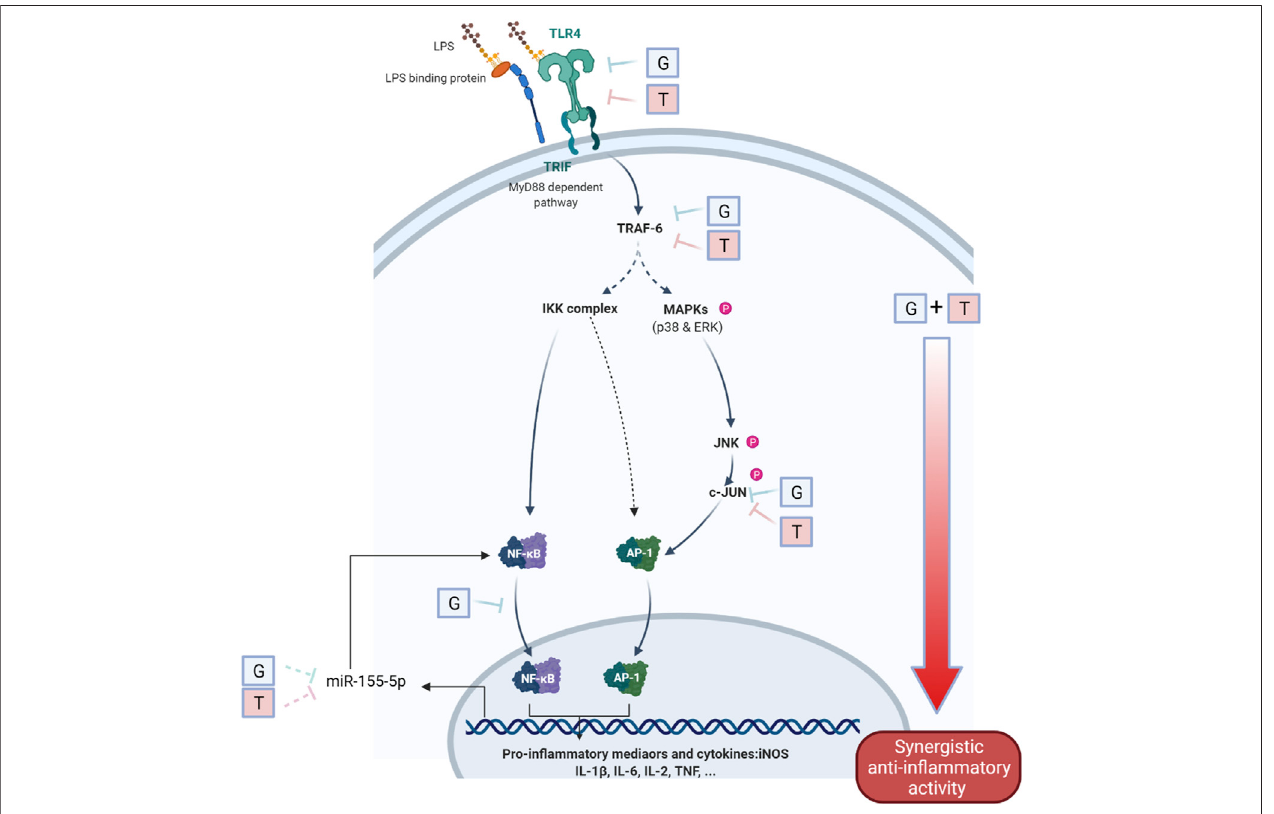
FIGURE 5 | Schematic diagram of the interaction of G and T on LPS-induced proin fl ammatory pathway. The synergistically enhanced activity of GT in reducing proin fl ammatory mediators may attribute to the accumulated combined individual activities of G and T in TLR4, TRAF6 and further strengthened downregulation in p-JNK and p-c-JUN. The inhibitory effect on miR-155 – 5p may further emphasized the inhibition of pro-in fl ammatory via a negative NF- κ B feedback loop.